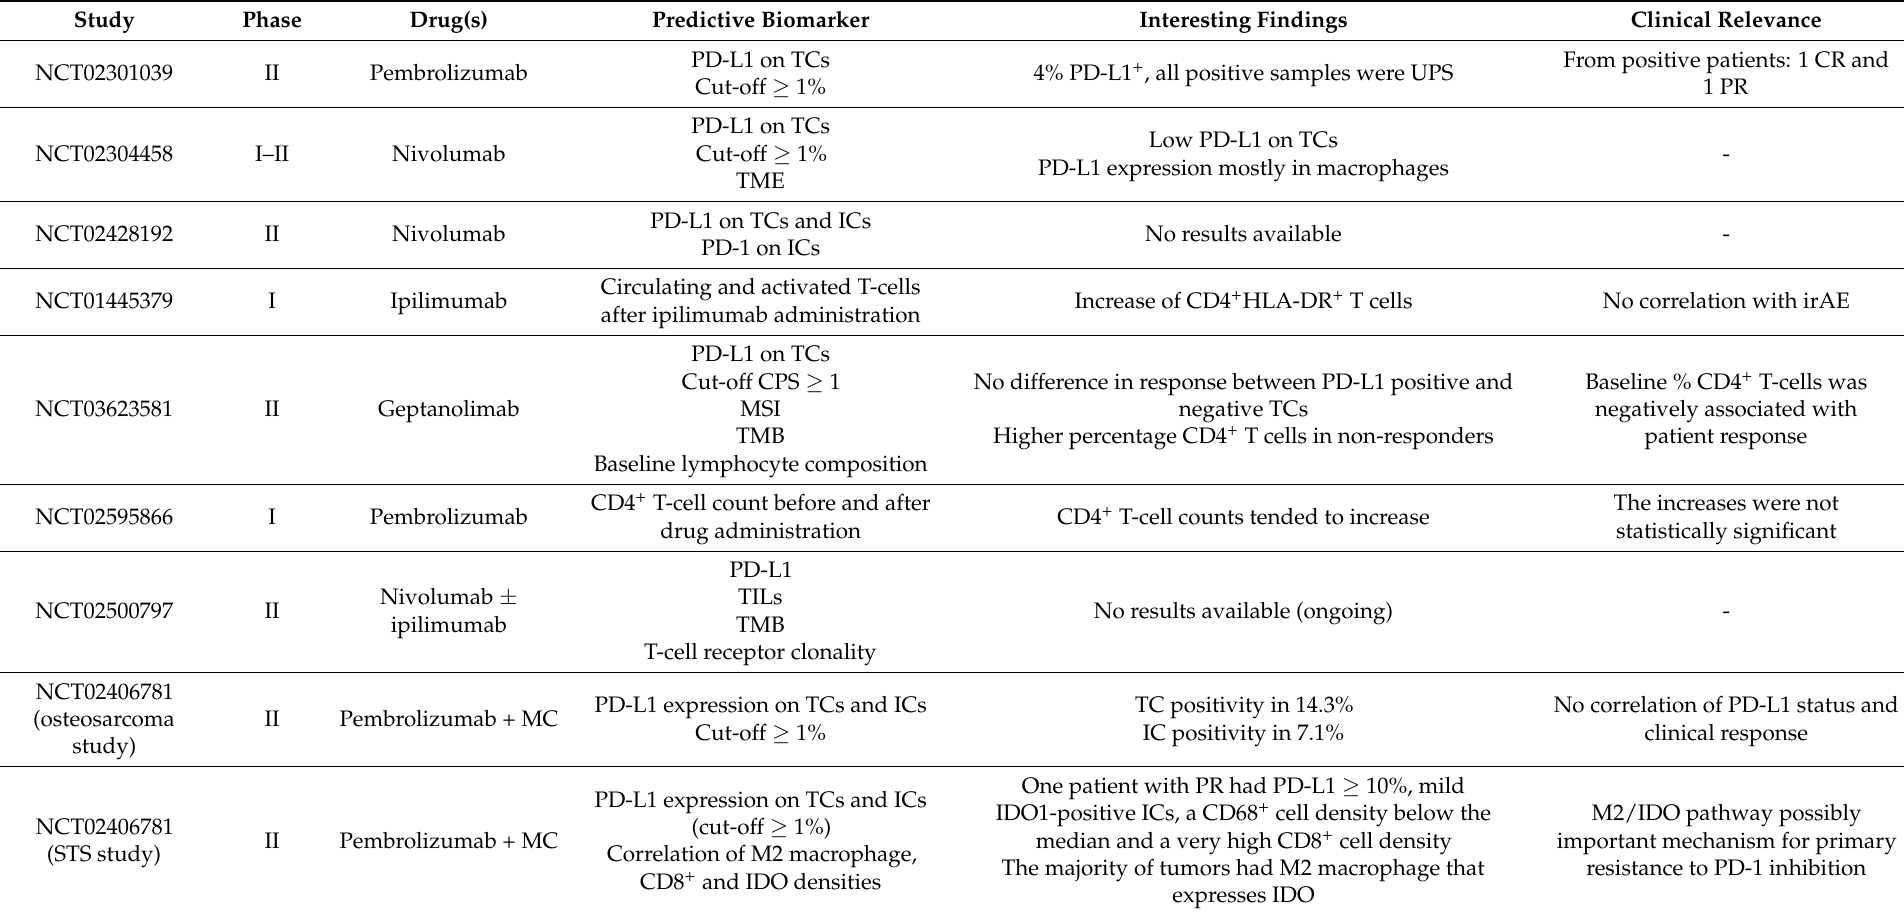
Table 2. Overview of the predictive biomarkers and their clinical importance investigated in the clinical trials described in this